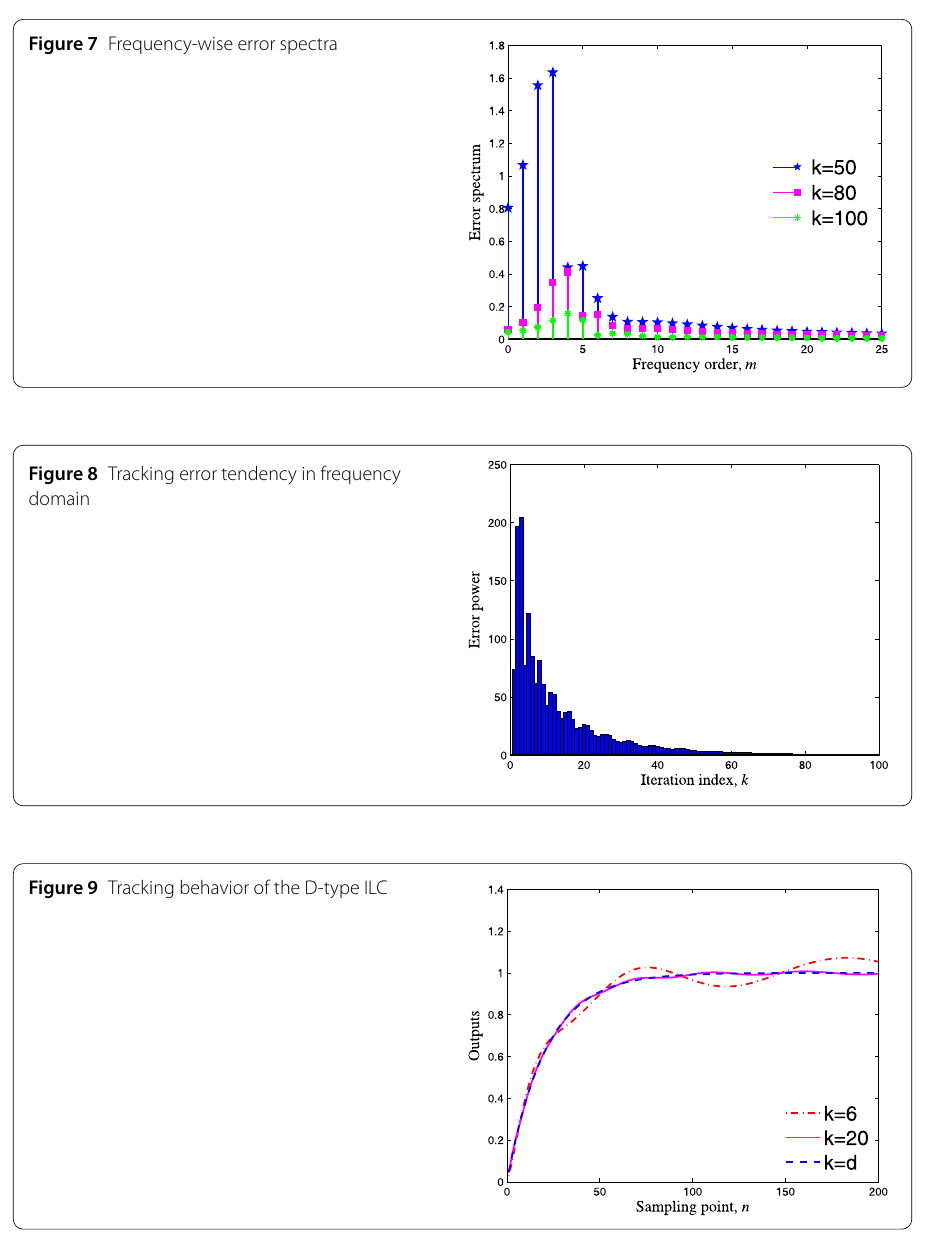
Figure 7 Frequency-wise error spectra